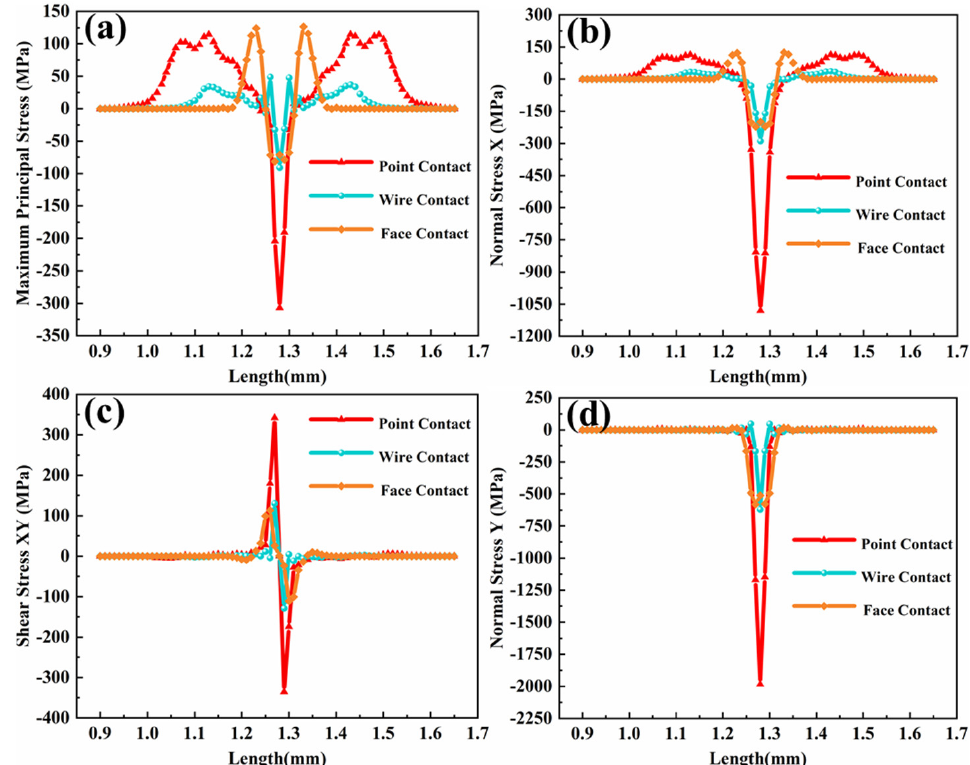
Figure 8. The plot of the ( a ) maximum principal stress, ( b ) normal stress X, ( c ) shear stress XY and ( d ) normal stress Y as the function of length at the same impact velocity and impact angle with a different shape of CMAS particle.